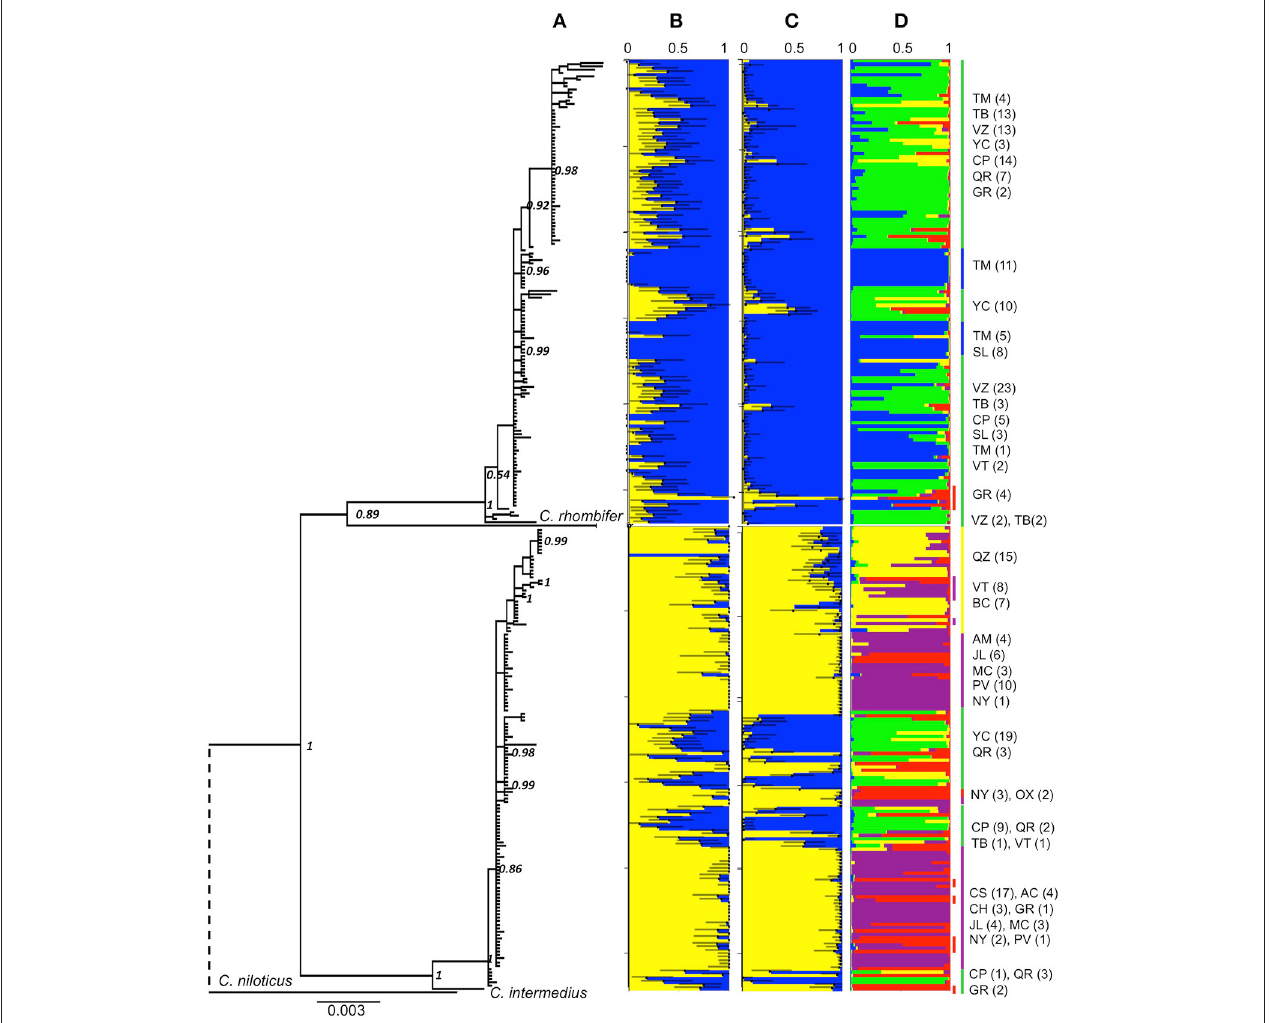
FIGURE 2 | Phylogenetic relationships, genetic structure, admixture and hybridization in Crocodylus acutus and C. moreletii from Mexico. (A) Individual-based Bayesian phylogenetic analysis based on the concatenated genes (cytb-tRNAPro-tRNAPhe-d-loop) for Crocodylus acutus (bottom clade/cluster) and C. moreletii (upper clade/cluster) from Mexico. The scale bar represents substitutions per site. (B) Maximum likelihood estimates of hybrid indexes obtained with nuclear markers (microsatellites), where solid lines are 95% confidence intervals and blue and yellow bars represent the statistical proportion of the hybrid index ( h ) for C. moreletii and C. acutus , respectively. Admixture proportions from STRUCTURE with (C) K = 2 and (D) K = 5; in the latter the different colors indicate the ancestry of the different clusters: C. acutus from Caribbean islands (yellow), C. acutus from Pacific (group 1; purple), C. acutus from Pacific (group 2; red), C. moreletii (blue) and hybrids (green). Each horizontal bar in (B–D) corresponds to an individual (haplotype) as depicted from the Bayesian phylogenetic analysis (mtDNA). Letters refer to sampling localities (see Figure 1 and Table S1 ), with sampling size in